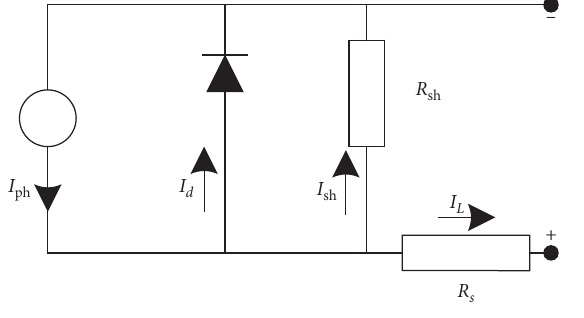
Figure 1: Equivalent circuit diagram of SDM.